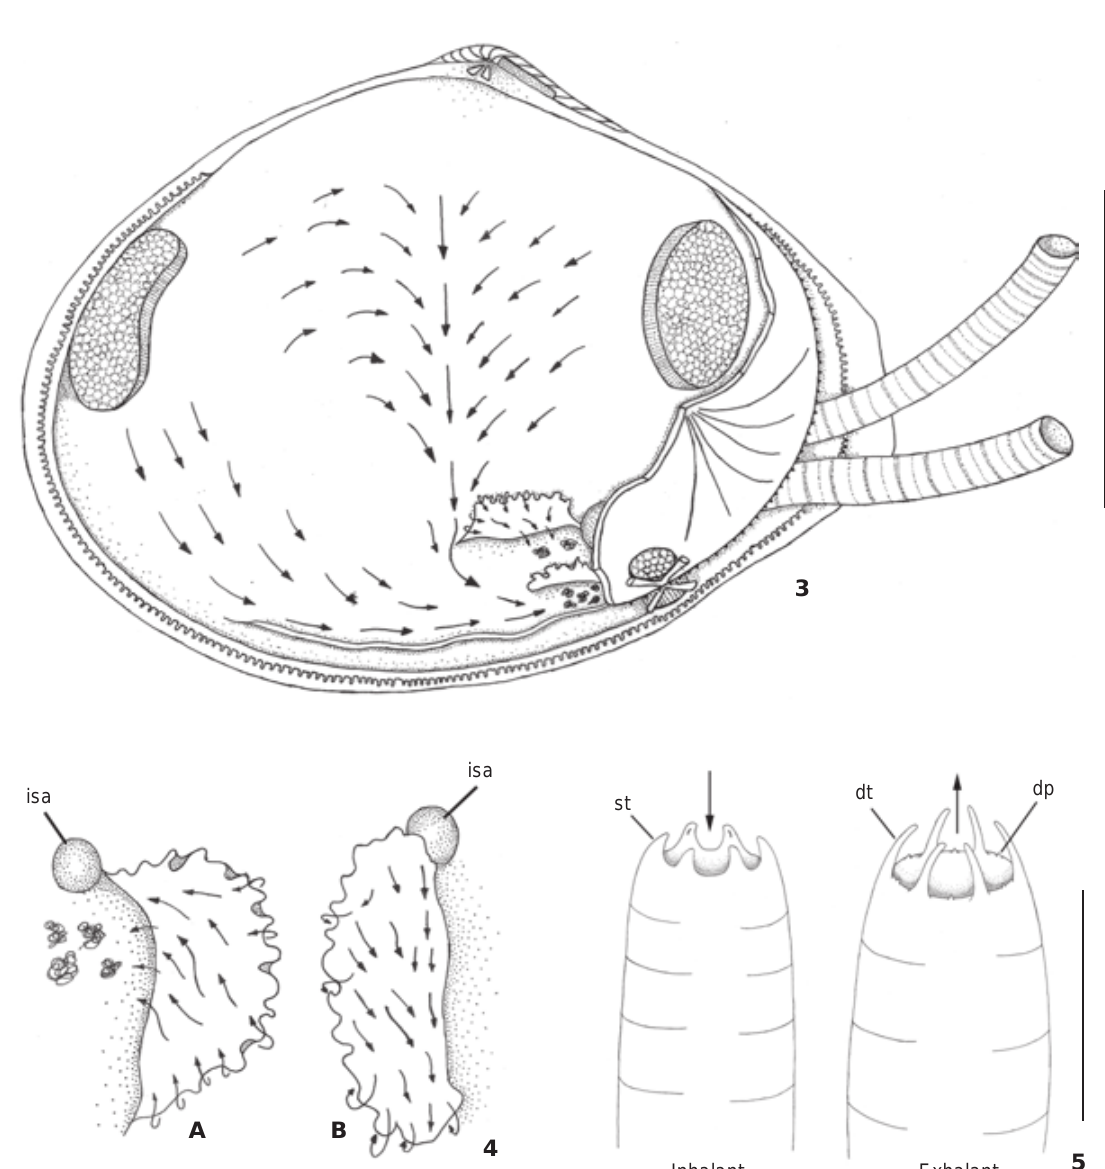
Figures 3-5. Macoma biota . (3) Ciliary currents on the inner surface of the right mantle lobe. Observe the accumulation of pseudofeces in the space formed by the additional mantle fold. (4) Ciliary currents on the surface of the left siphonal organ; (A) ventral surface, (B): dorsal surface. (5) distal extremity of the siphons, showing the inhalant aperture with six lobular small tentacles and the exhalant aperture with six small digitiform tentacles, intercalated by digitiform papillae. (dp) Digitiform papillae, (dt) digitiform tentacle, (isa) Inhalant siphon proximal aperture, (st) small tentacle. Scale bars: 3 = 1.5 cm, 4 = 5.0 mm, 5 = 2.0